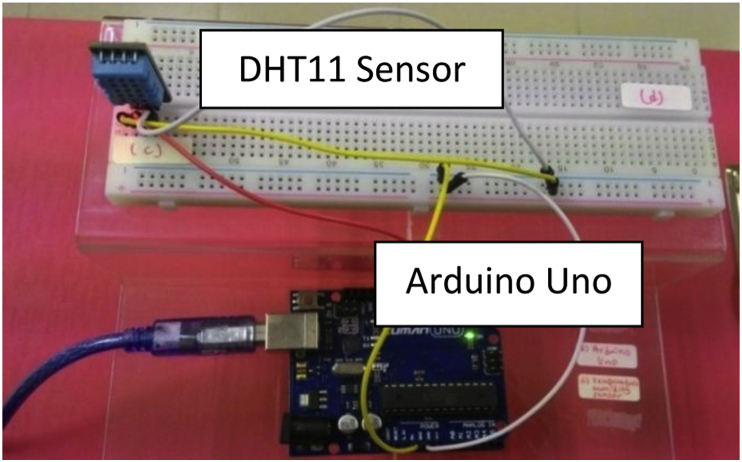
Circuit assembly.